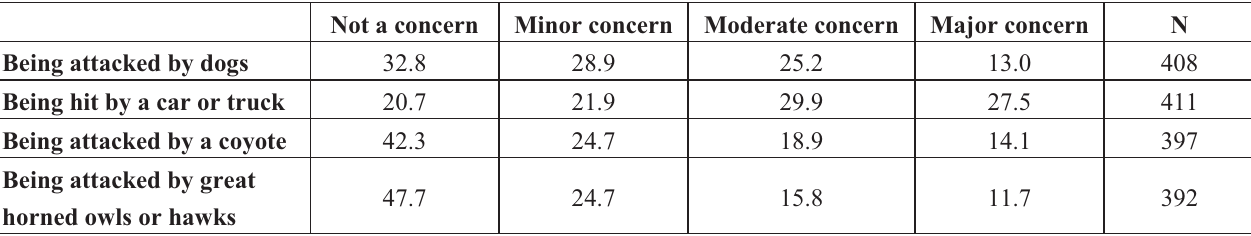
Table 9. Non-pet owners’ responses to: “Please indicate how concerned you are that the following could happen to cats that are unsupervised and off-leash in the D.C. metro area.” Given in